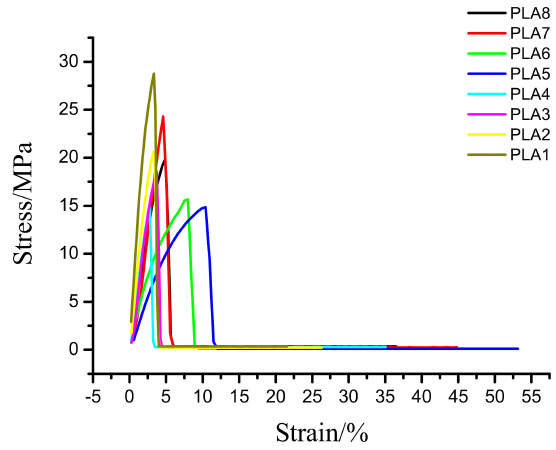
Figure 7. Plot for tensile data. Stress strain diagram Table 5. Tensile test results of BSP / PLA composite film.